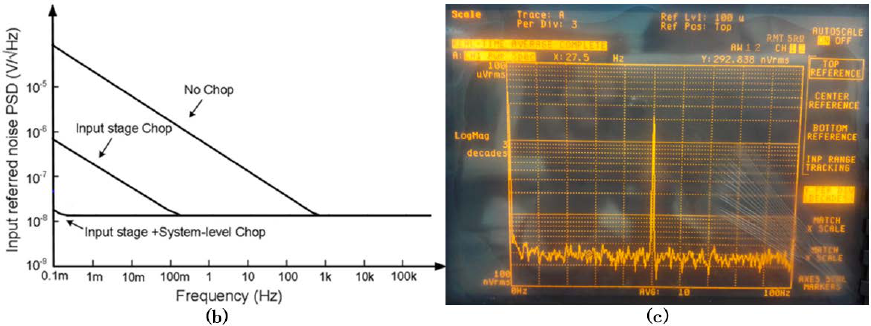
Figure 6. ( a ) Current feedback instrumentation amplifier (CFIA) circuit structure with ripple reduction loop ( b ) Simulating noise spectrum of with various noise chopper techniques ( c ) The power spectrum noise of CFIA.